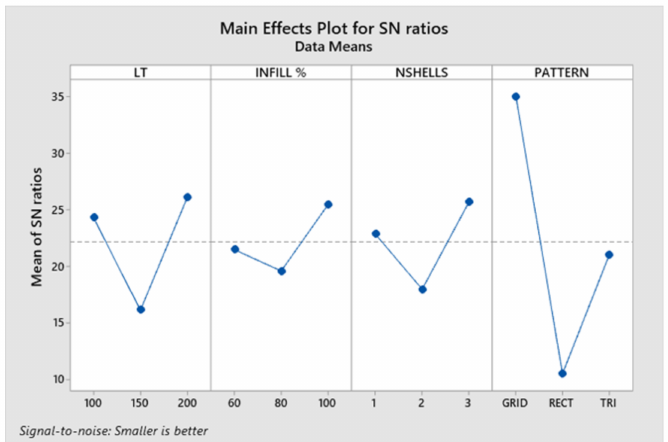
Figure 5. Main e ff ects plot for signal-to-noise (S / N) ratio. LT, layer thickness; INFILL%, infill rate; NSHELLS, number of shells; PATTERN, infill